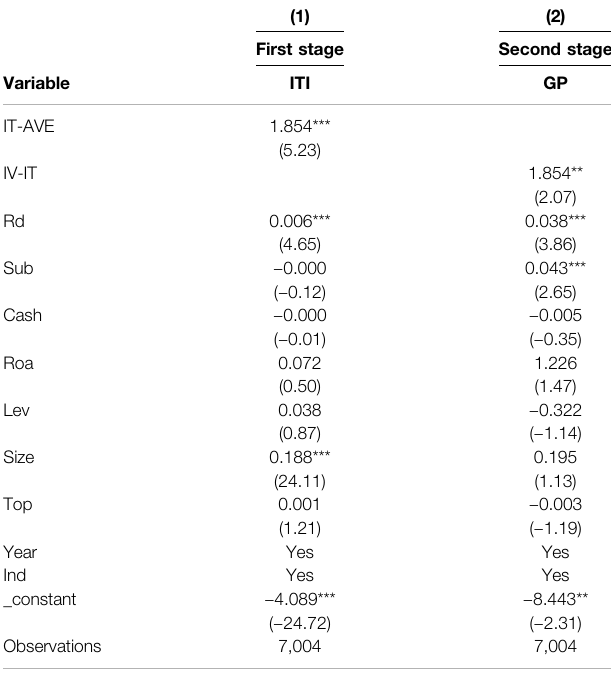
TABLE 6 | Endogenous treatment: regression results after PSM. TABLE 7 | Test results based on IV Tobit